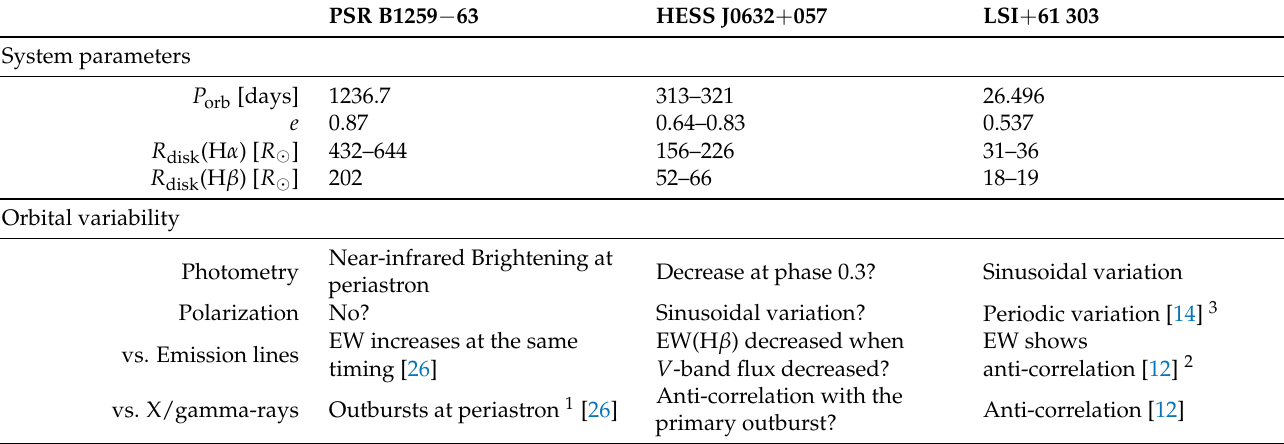
Table 2. Summary of the observed variations and the system parameters in the three gamma-ray binaries with a Be